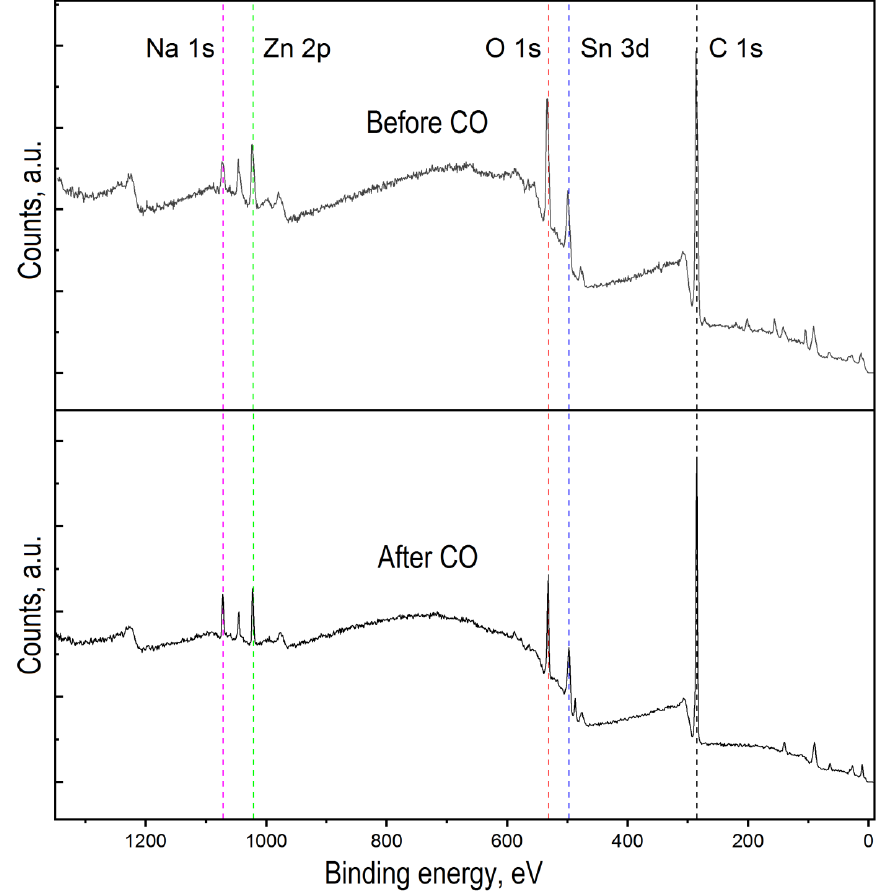
Figure 5. Overview spectra of ZTO before and after CO treatment.